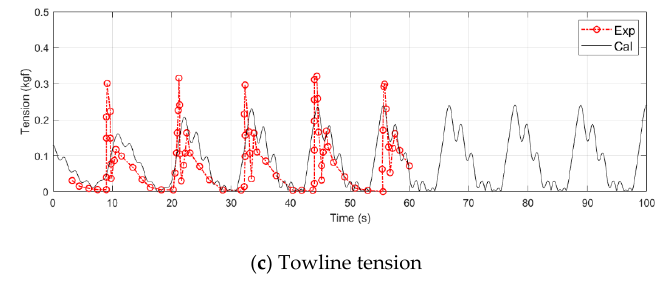
Figure 2. Time histories of the towed vessel motion and towline tension.